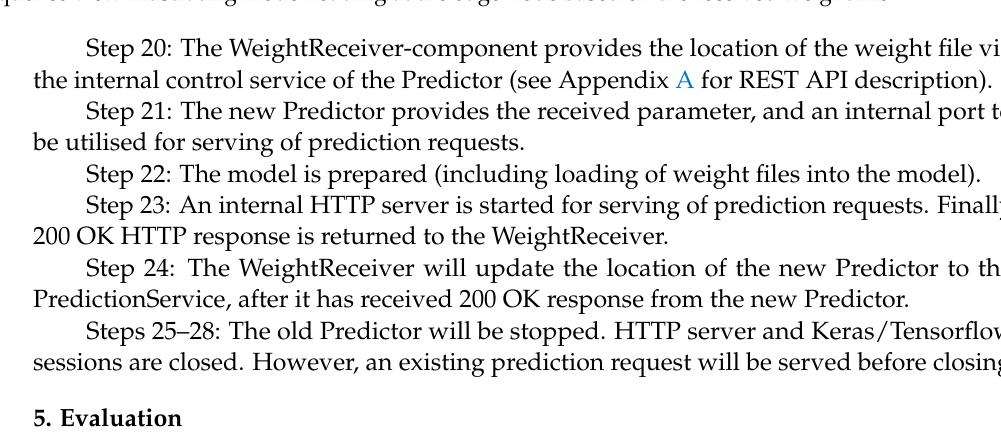
Figure 7. UML sequence view illustrating model loading at the edge-node based on the received weight file.